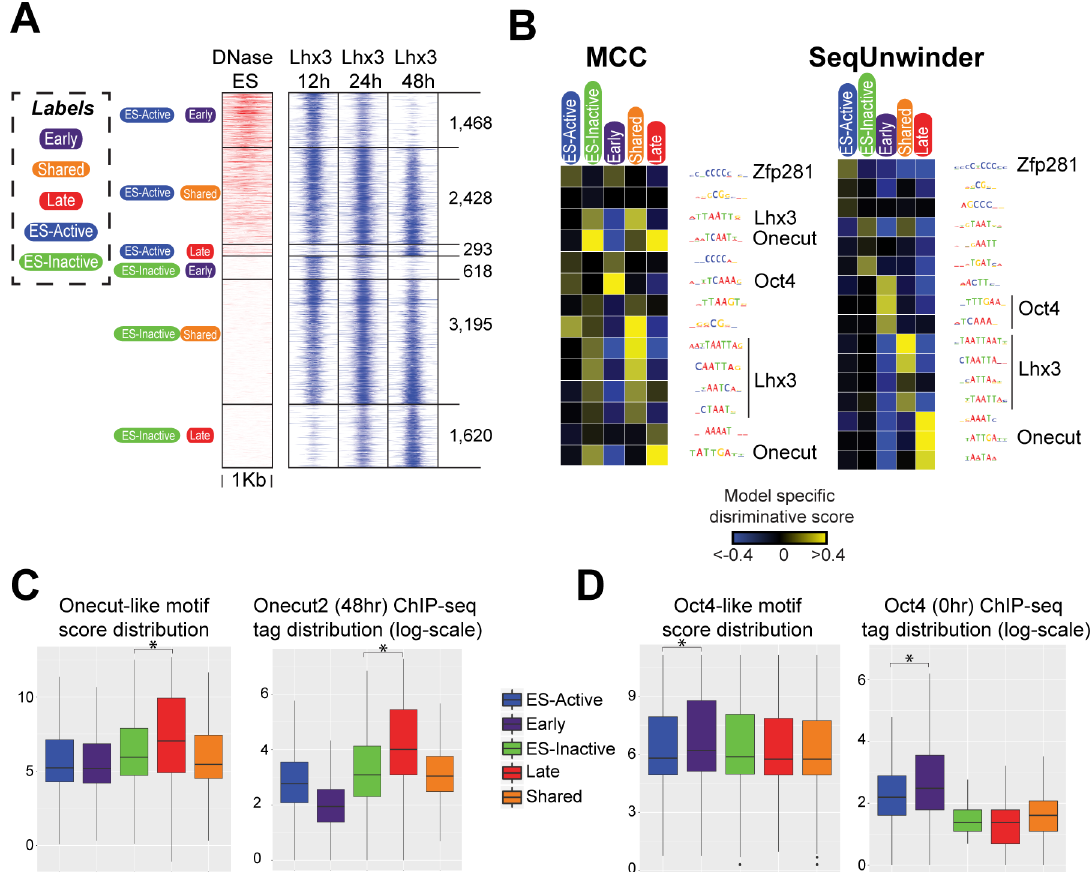
Fig 3. SeqUnwinder analysis of Lhx3 binding classesduring iMN programming. (A) Lhx3 bindingsites labeledusing their dynamic bindingbehavior and ES chromatinactivity statuses. (B) Label-specific scores of de novo motifs identified at Lhx3 binding sites definedin “A” using MCC (left) and SeqUnwinder (right) models. For consistency across figures, we fix the color saturation values to -0.4 and 0.4. (C) Log-oddsscore distribution of de novo discovered Onecut-likemotif at “ES-active”, “ES-inactive“, “Early”, “Shared”, and “Late” sites (left panel). Distributionof Onecut2 (48hr) ChIP-seq tag counts in log-scaleat “ES-active”, “ES-inactive“, “Early”, “Shared”, and “Late” sites (right panel). (D) Log-oddsscore distributionof de novo discoveredOct4-like motif at “ES-active”, “ES-inactive“, “Early”, “Shared”, and “Late” sites (left panel). Distributionof Oct4 (0hr) ChIP-seq tag counts in log-scaleat “ES-active”, “ES-inactive“, “Early”, “Shared”, and “Late” sites (right panel). Statistical significancecalculatedusing Mann-Whitney-Wilcoxon test ( * : P-value < 0.001).